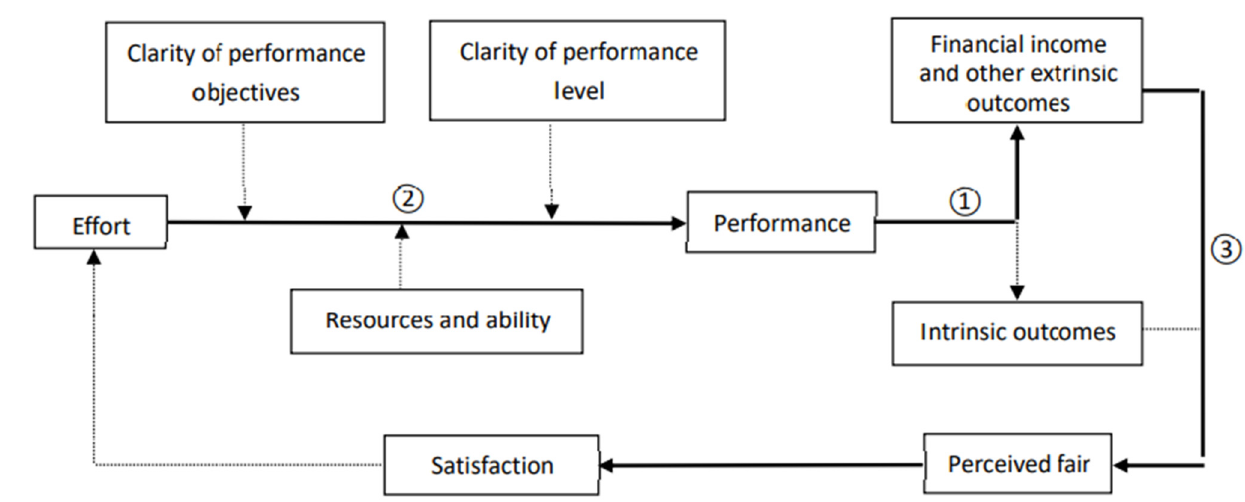
Figure 1. The framework of this study based on expectancy theory.